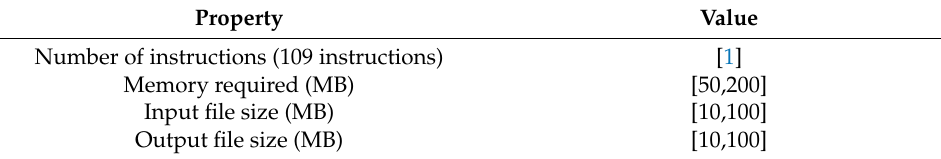
Table 2. Characteristics of the tasks to be assigned.